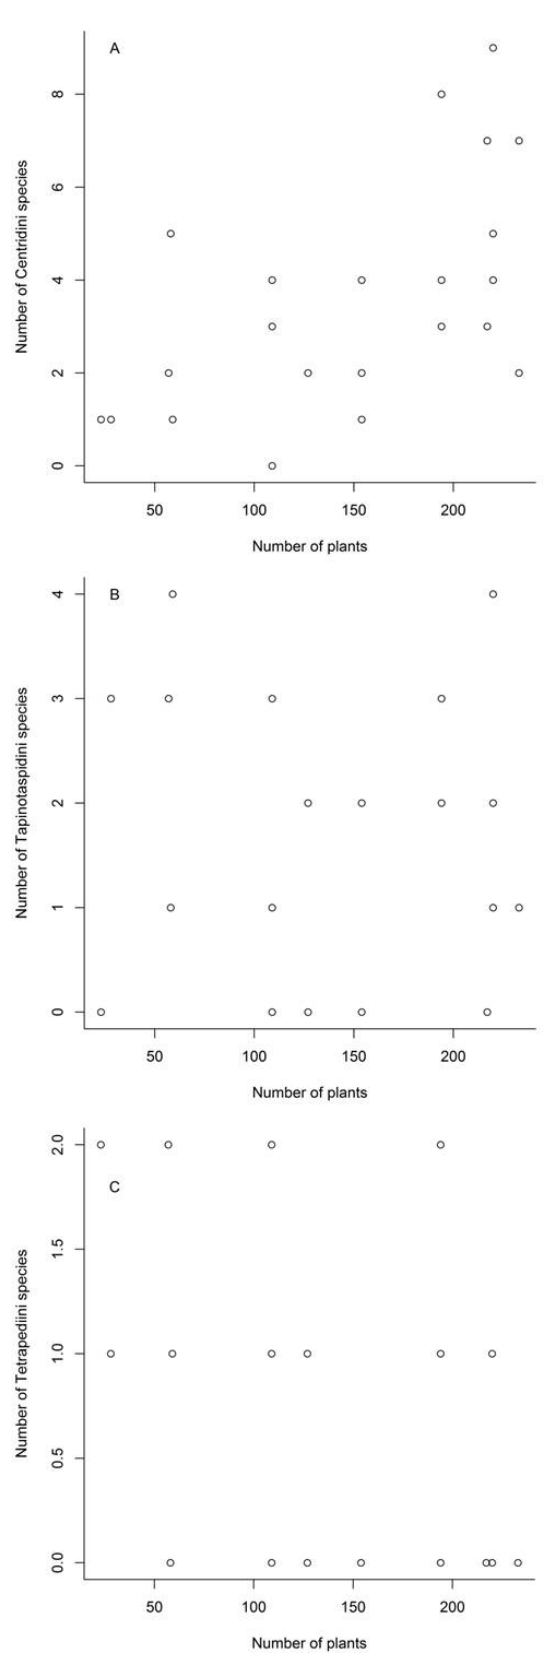
Fig 2. Number of bee species belonging to Centridini (a),Tapinotaspidini (b) and Tetrapediini (c) in relation to the number of Byrsonima plants in a cerrado area in Chapada Diamantina, northeastern